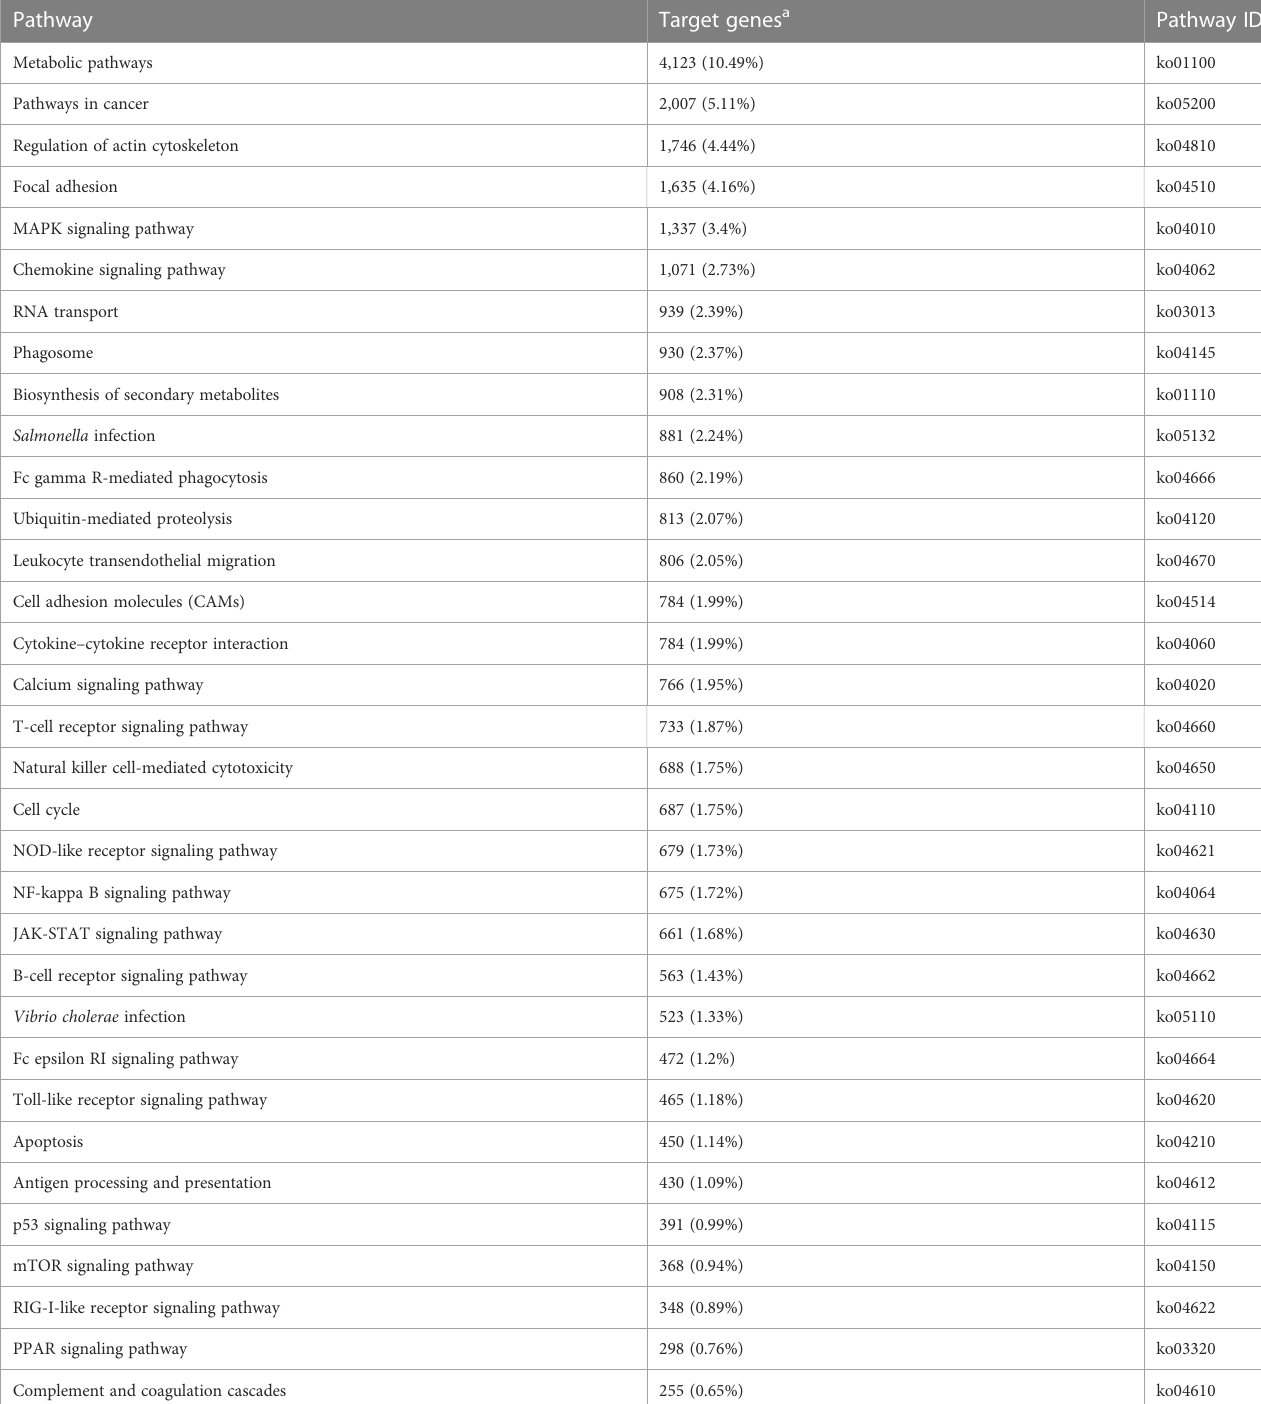
Complement and coagulation cascades *Target genes indicated with pathway annotation